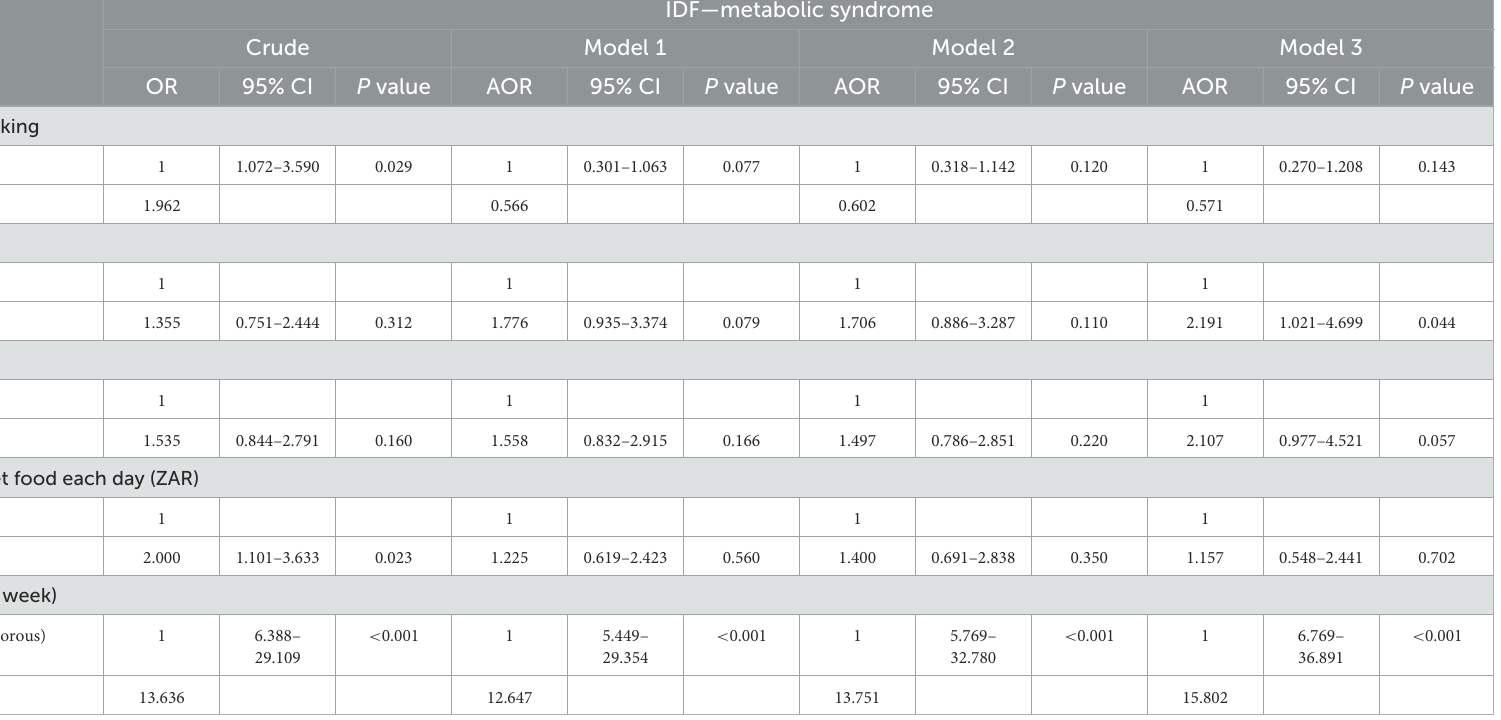
TABLE 6 Binary logistic regression analysis to show the association between the lifestyle factors and MetS status of the South African minibus taxi